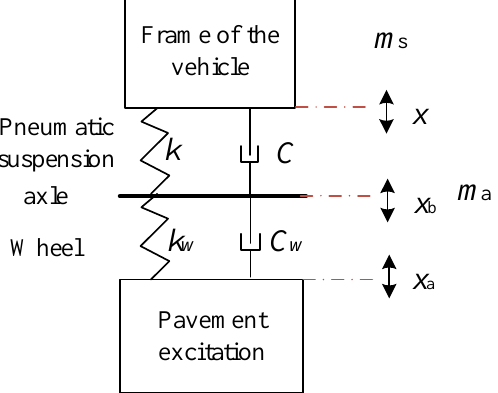
Figure 4. The schematic diagram of the 1/4 vehicle pneumatic suspension.